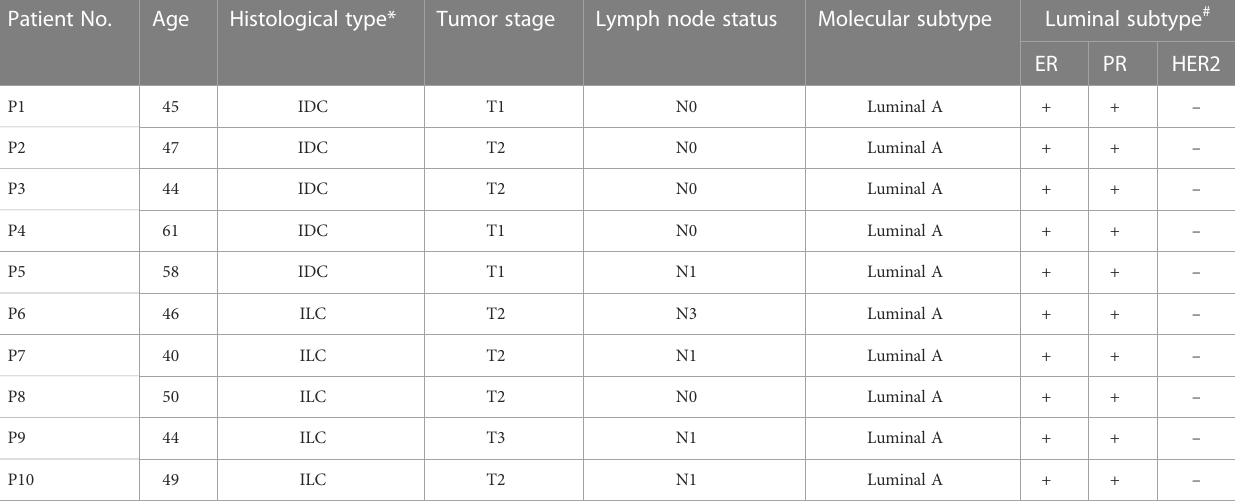
TABLE 1 Summary of clinical information on the ten subjects involved in this study. Patient